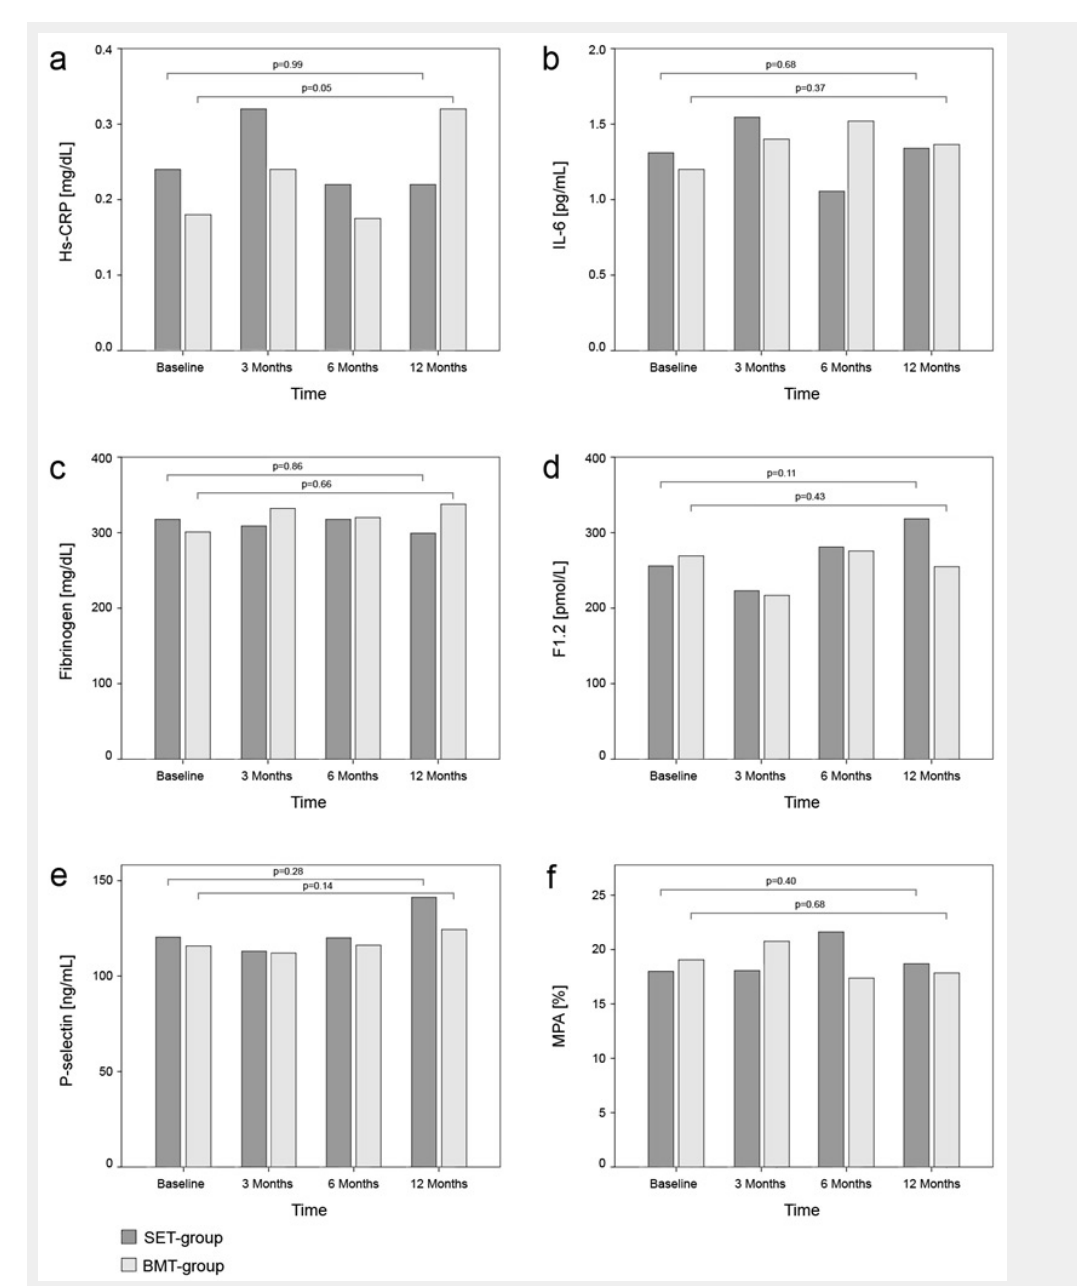
Figure 2 Bar chart indicating median values of markers of high sensitivity C-reactive protein (hs-CRP), interleukin-6 (IL-6), fibrinogen, soluble P-selectin, prothrombin fragment 1+2 (F1.2) and monocyte-platelet aggregates (MPA) at baseline, after three, six and twelve months. Friedman test for distribution free, repeated-measures analysis of variance was used to test for significant changes within the groups over time